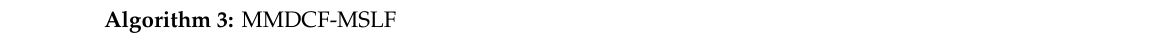
Algorithm 3: MMDCF-MSLF